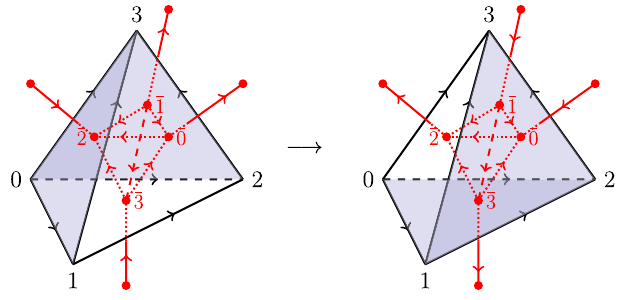
˜ P FIG. 14. Conventions for orientations of links in (red line) FIG. 15. Shape changing of singular surfaces S of T and gauge from branching structure of triangulation T (black line). Non- transformation of Kasteleyn orientations of singular (singular) black (blue) triangle f ∉ S ð f ∈ S Þ induces transformations on the four red vertices inside a black tetrahe- ˜ P orientation for the dual link in . We introduce a spinless fermion dron, which effectively changes the shape of S and the directions on each (black or blue) triangle in T and split it into two of the four outreaching red links. The Majorana fermions are ˜ P mapped with respect to the directions of red links dual to black Majorana fermions on two sides of this triangle or vertices of triangles under this FSLU (red